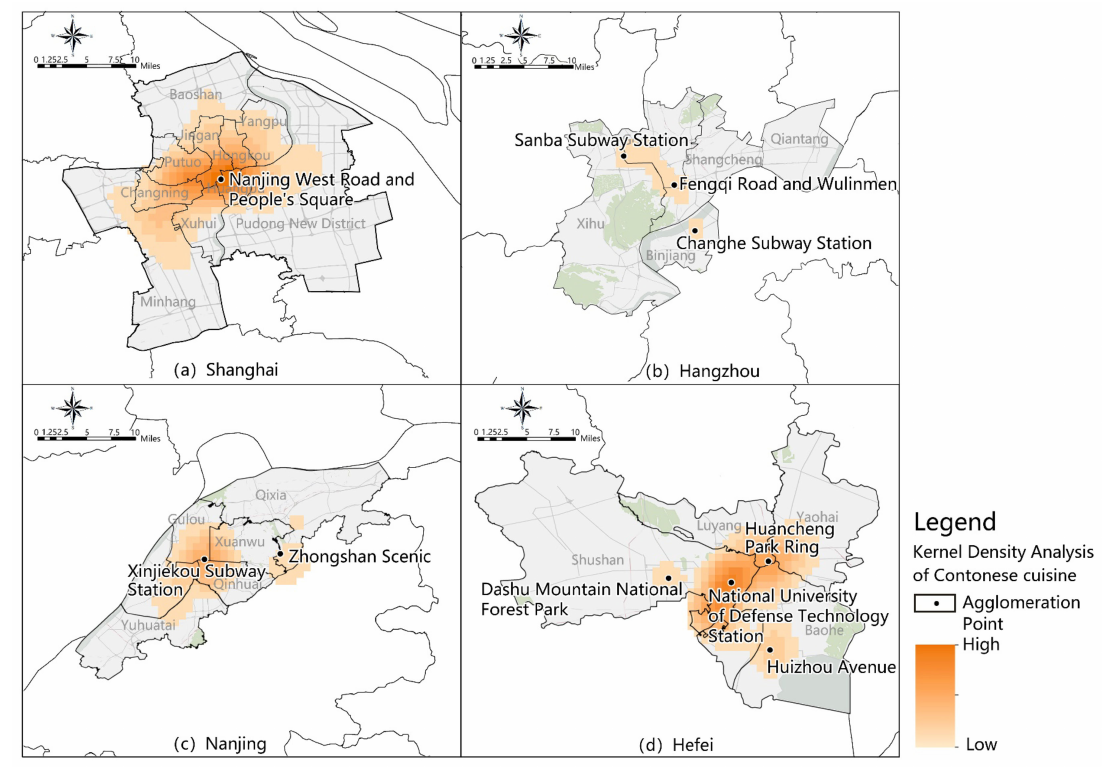
Figure 12. Kernel density analysis of Cantonese cuisine in the main urban areas of the four central cities in the YRD.